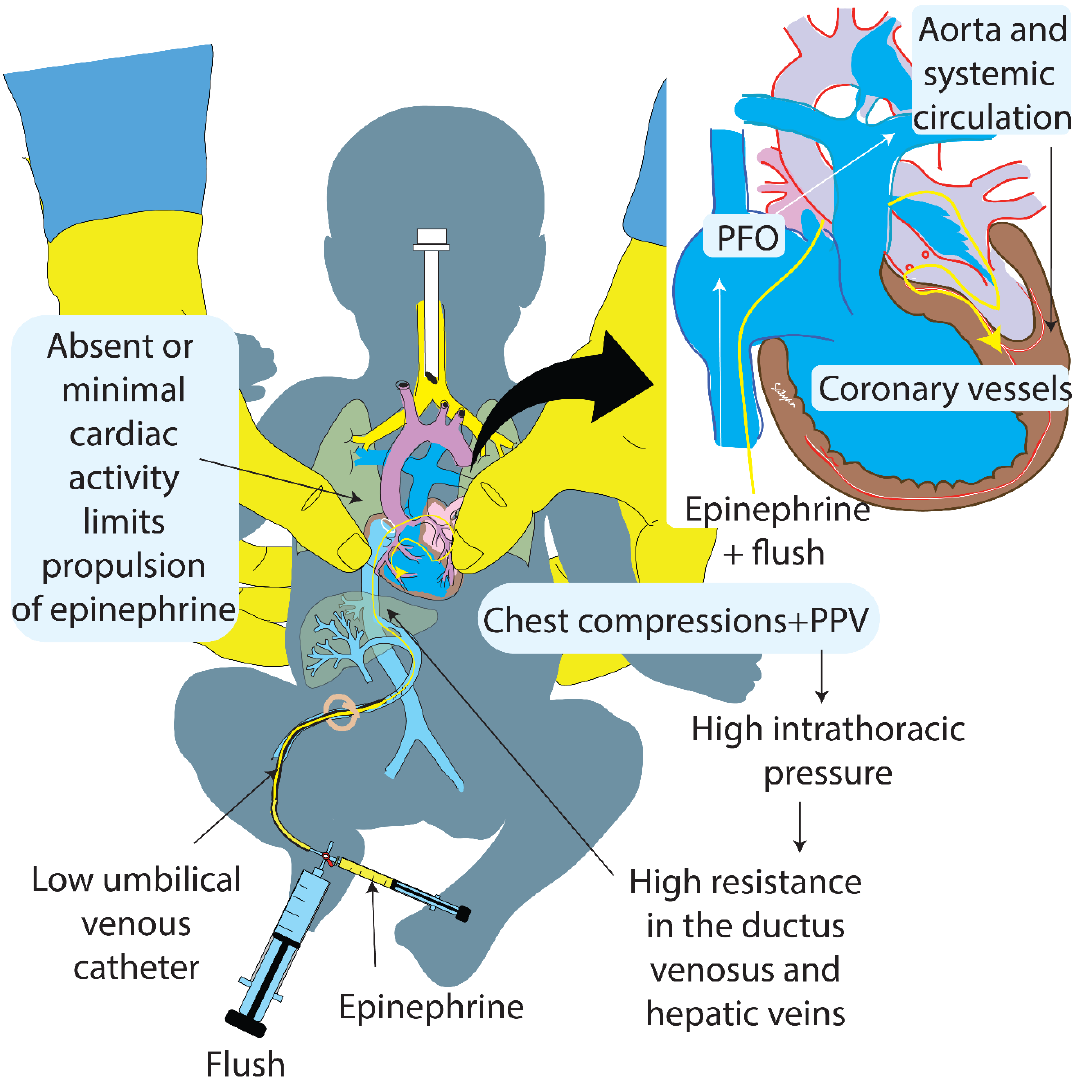
Figure 1. Schematic showing the speculative mechanism of larger flush volume following low umbilical venous catheter (UVC) epinephrine in term newborns. During cardiac arrest (absence of spontaneous cardiac activity) and during chest compressions and positive pressure ventilation (PPV) that increase the intrathoracic pressure and cause back pressure in the inferior vena cava, the epinephrine injected via a low umbilical venous catheter followed by a low flush volume of 0.5 mL to 1 mL may not be delivered to the right atrium. The epinephrine may be deposited in the umbilical vein or hepatic veins. The use of a higher flush volume may propel the epinephrine to the right atrium and across the patent foramen ovale (PFO) to left heart, aorta, systemic circulation, and coronary arteries increasing the chances of return of spontaneous circulation (ROSC). Inset shows a magnified view of the heart and coronary vessels. The yellow line represents the path of epinephrine and flush in the figure and the inset. Copyright Satyan Lakshminrusimha.